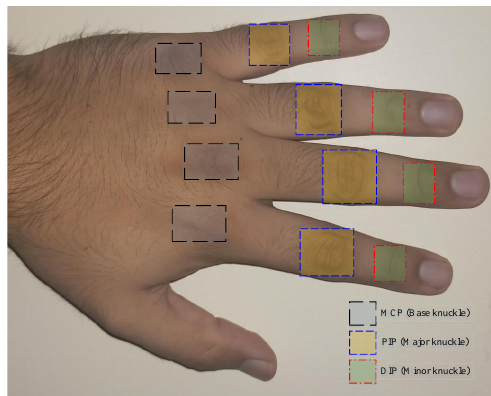
Figure 1. Depiction of MCP, PIP, and DIP joints on dorsal view of